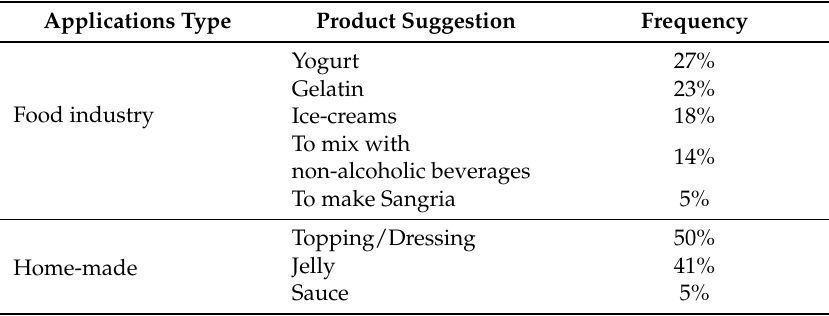
Table 6. Possible applications of Bissap in